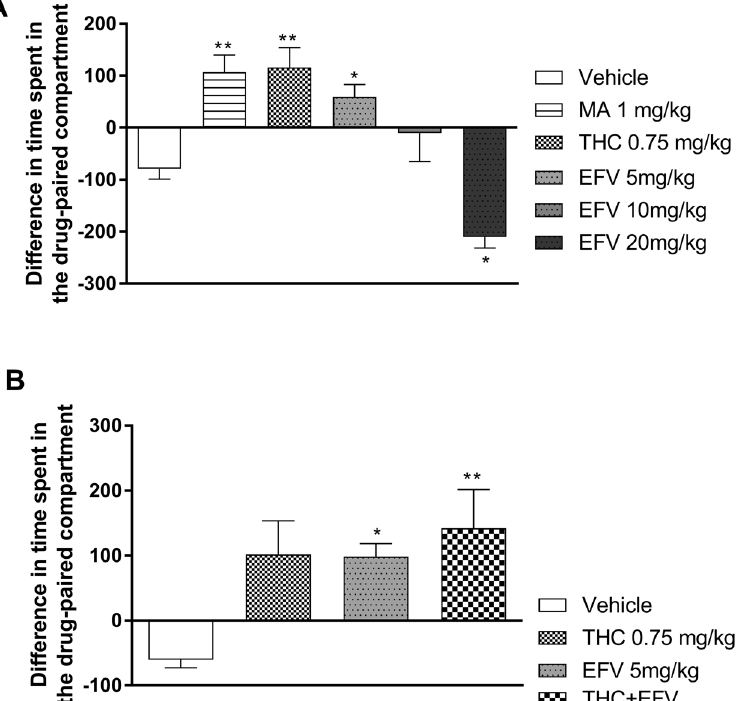
Figure 2. Conditioned place preference (CPP) test in ( A ) the sub-acute and ( B ) the sub-chronic exposure groups. Data presented as difference in time spent in drug-paired compartment: Time spent during the habituation in the drug-paired compartment (s) – time spent during the post-test in the drug-paired compartment (s). Tetrahydrocannabinol (THC); Efavirenz (EFV); Methamphetamine (MA). * p < 0.05, ** p < 0.01, vs. Vehicle (One-way ANOVA, Dunnett’s multiple comparison (sub-acute study) and Bonferroni’s post hoc test (sub-chronic